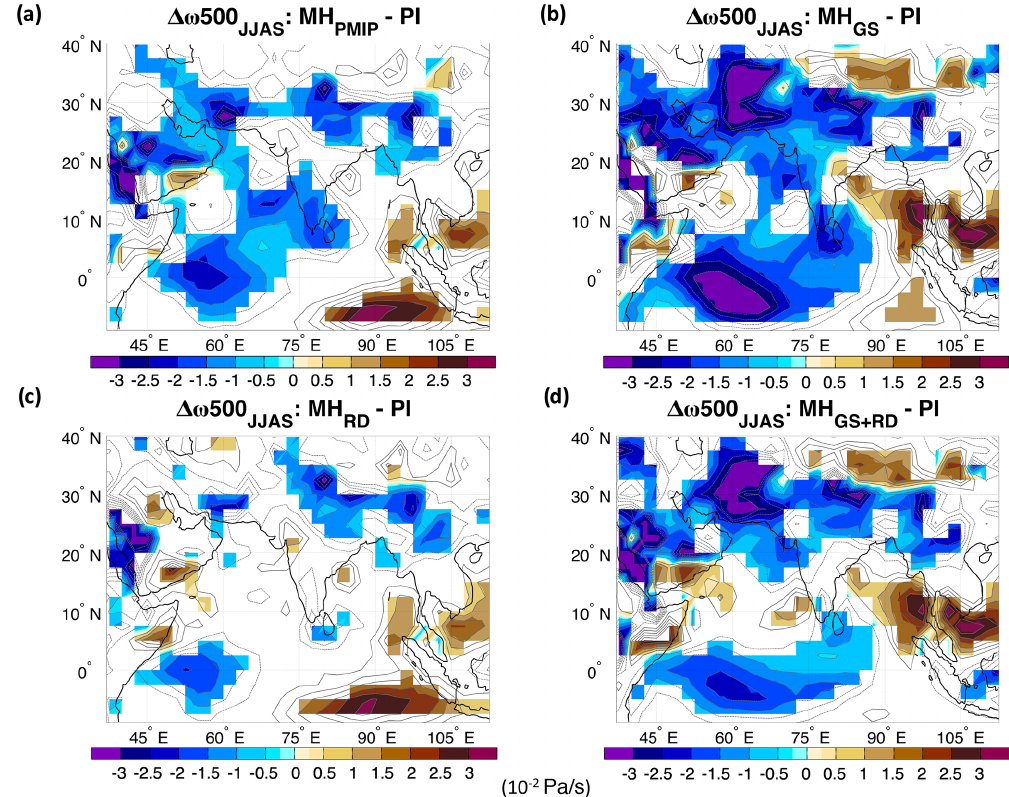
Figure 9. Changes in summer (JJAS) vertical pressure velocity at 500hPa ( ω 500; Pa/s) for the (a) mid-Holocene-only orbital forc- ing (MH PMIP ); (b) the Sahara greening (MH GS ); (c) the dust-only reduction (MH RD ); and (d) the Sahara greening and dust reduction (MH GS + RD ) experiments relative to the PI reference simulation. The contour lines follow the color-bar scale (the 0 lines are omitted for clarity). Only differences significant at the 95% confidence level using the Student t test are